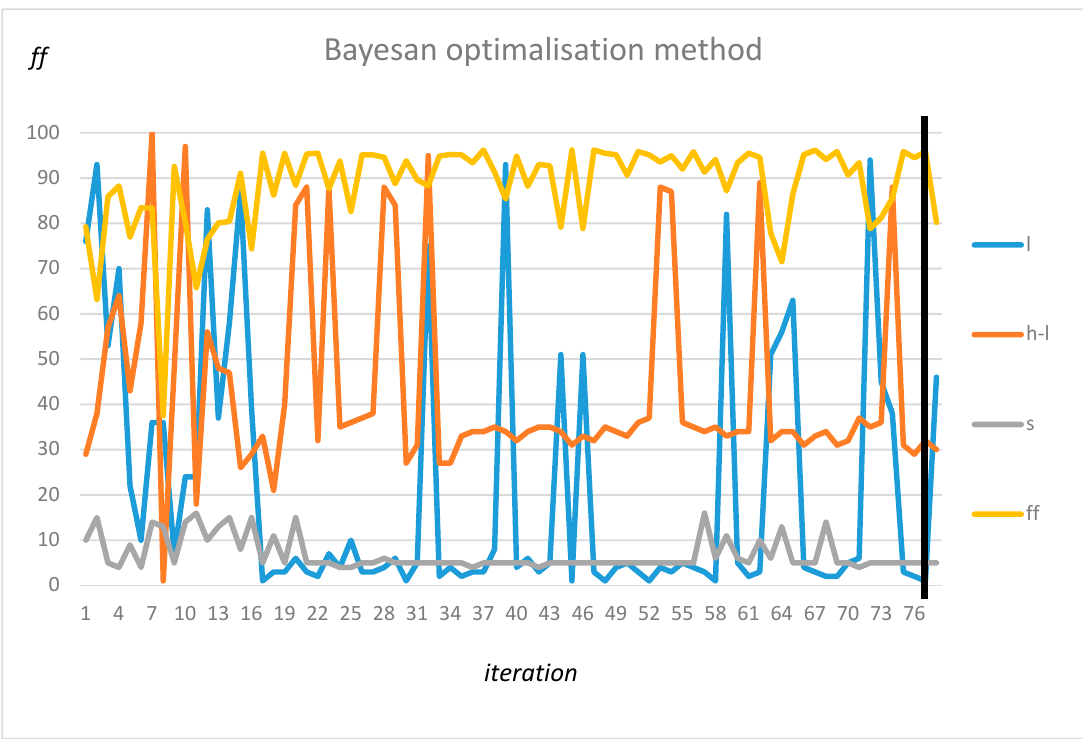
Figure 15. Optimization using Bayesian approach.